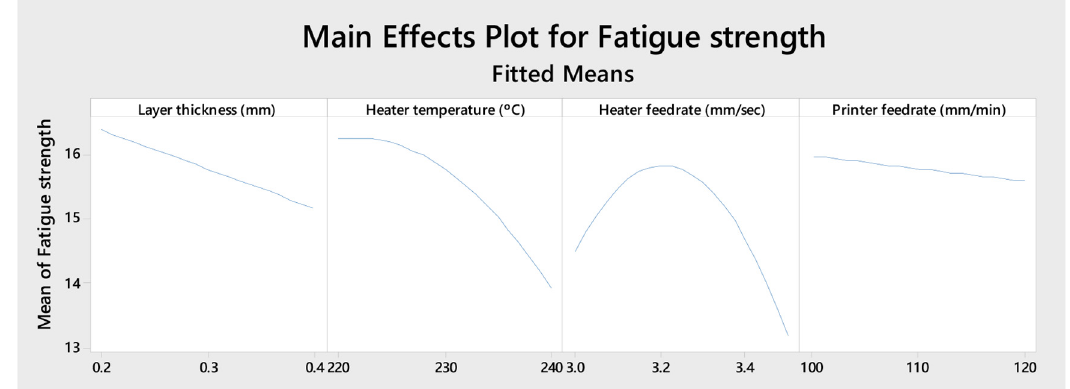
Fig. 6. Main effect of SIS process variables on fatigue strengths of